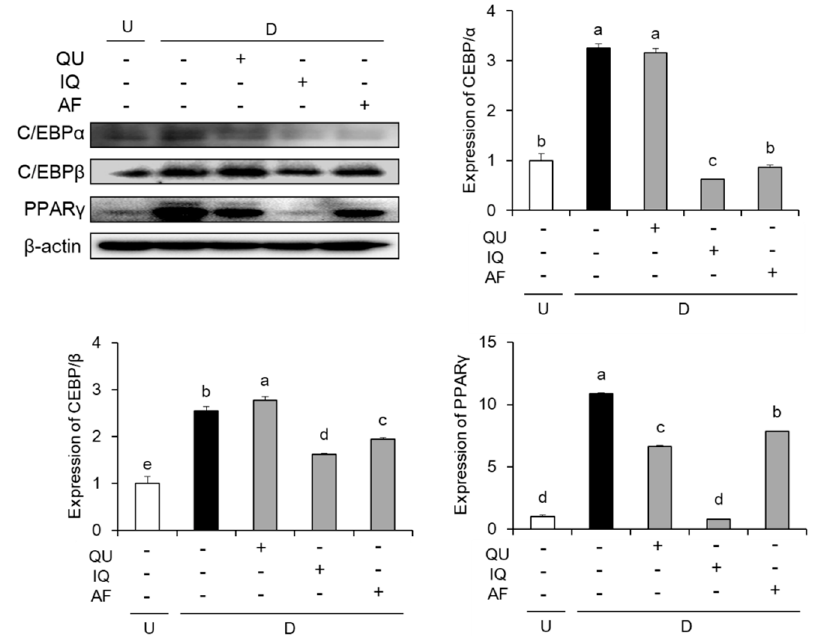
Figure 4. Effects of flavonoids from Acer okamotoanum (10 µg/mL) on adipogenic key transcription factors in differentiated 3T3-L1 cells. Adipocyte differentiation was induced by treatment with MDI media in the absence or presence of flavonoids from A. okamotoanum during 2 days. The MDI media was then replaced with insulin media, and it was changed four times for every 2 days. Data are expressed as the mean ± standard deviation. a–e Means with different letters indicate significant differences ( P < 0.05) by Duncan’s multiple range test. β -actin was used as a loading control. Relative expression levels were normalized to the β -actin levels and the normal group. Normal group indicates non-differentiated cells, whereas control group indicates the differentiated cells by treatment of MDI media. U: Undifferentiation; D: Differentiation; QU: Quercitrin; IQ: Isoquercitrin; AF: Afzelin.